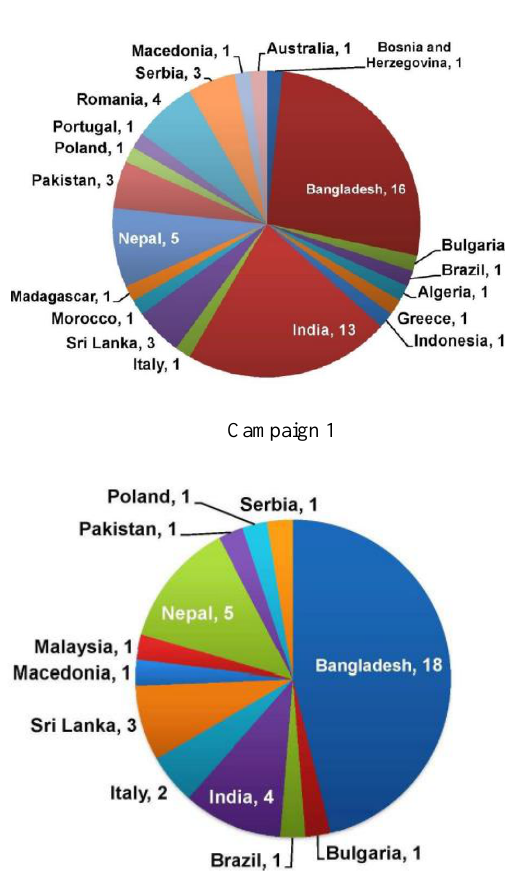
Figure 3. Origin of the crowdworkers